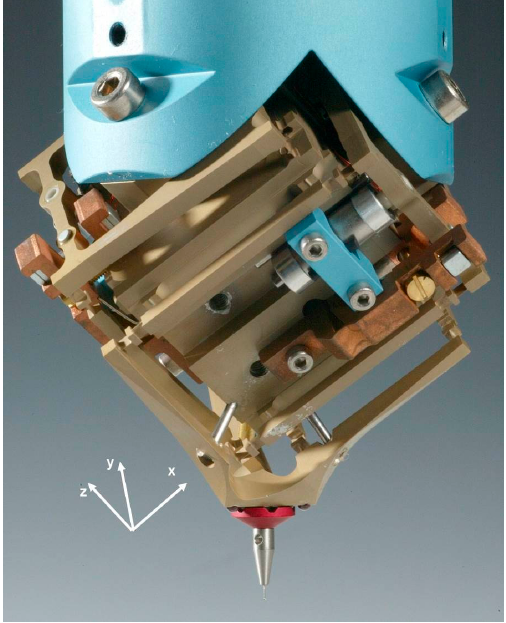
Figure 1. METAS tactile probe for micro parts (housing removed).